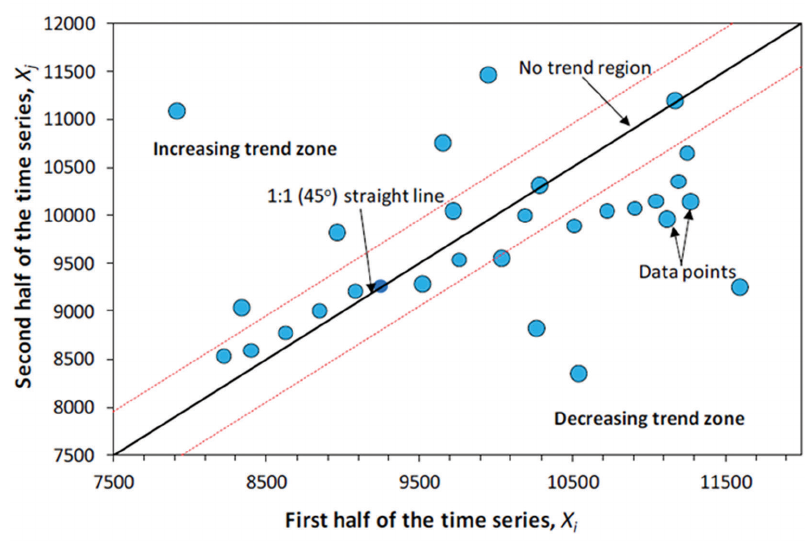
Figure 2. Graphical presentation of the IPTA method (Ali et al.,